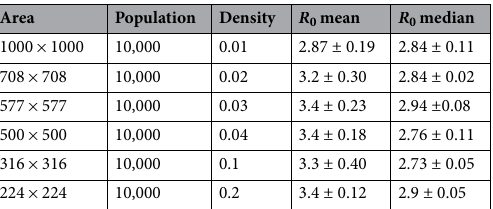
Table 1. The table compares the reproduction rate in different population density. The comparison is represented in a mean±standard-deviation format of the data collected in ten individual runs.